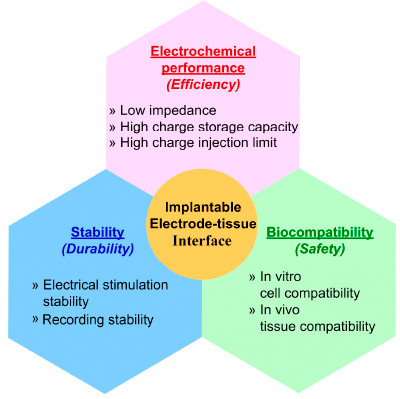
Figure 2. Characteristics of ideal implantable electrode–tissue interface.